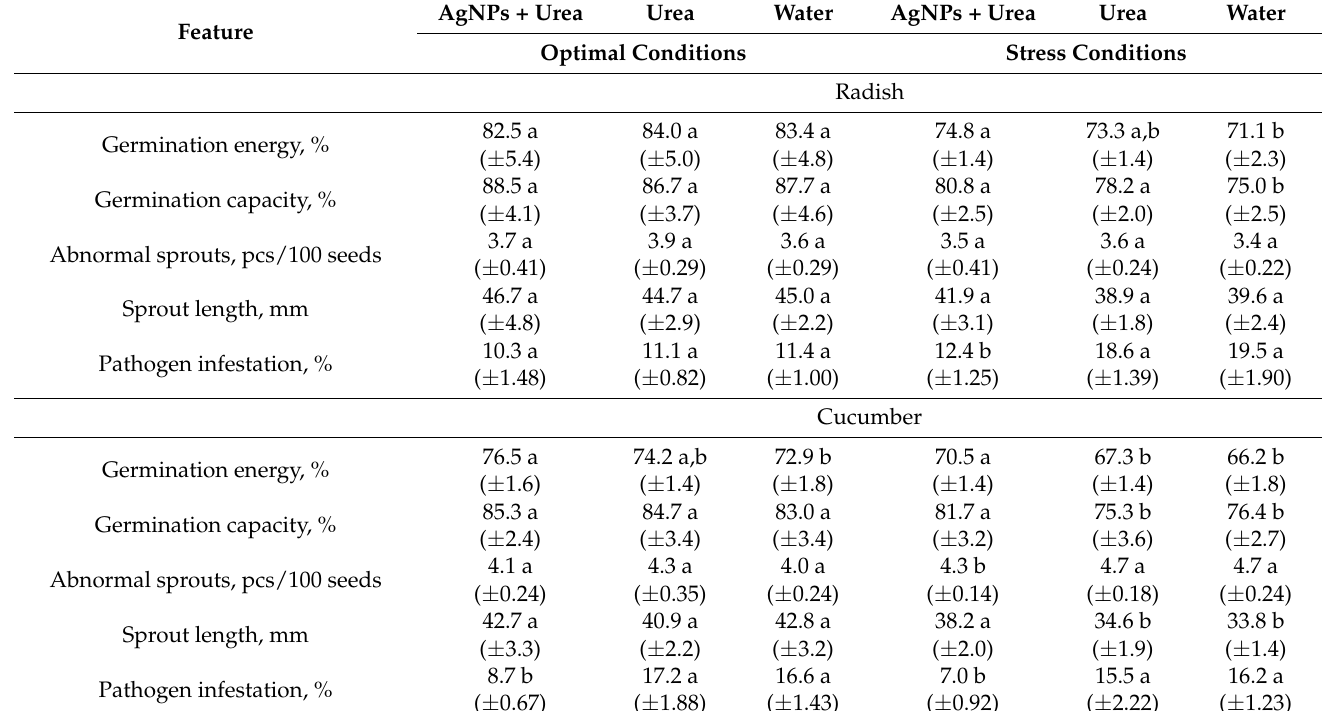
Table 4. Germination of vegetable seeds in the presence of AgNPs in the substrate; urea solution